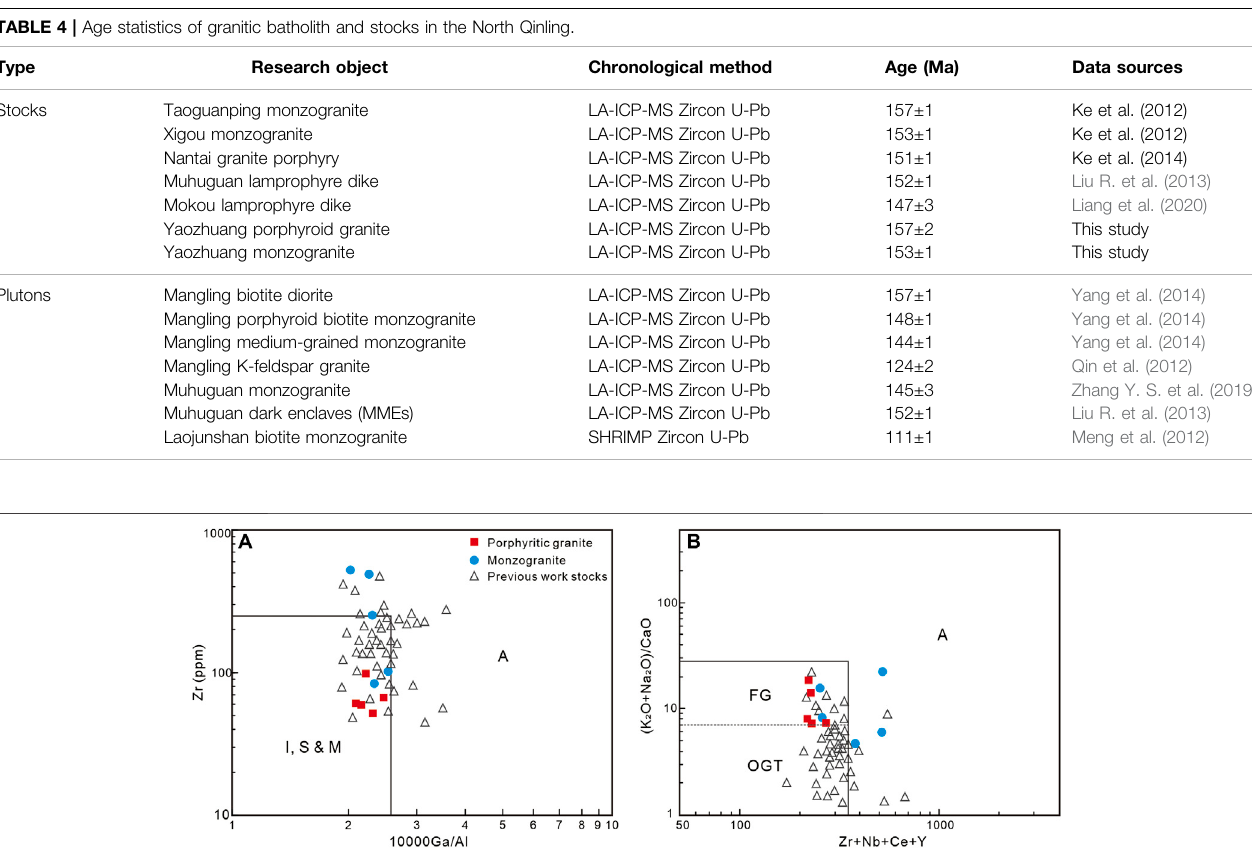
FIGURE 6 | Zr-10000Ga/Al diagram [ (A) after Joseph et al., 1987] and (K 2 O + Na 2 O)/CaO-Zr + Nb + Ce + Y diagram [ (B) after Joseph et al., 1987; previous work stocks data after Ke et al., 2012a; Qin et al., 2012; Yang et al., 2014; Hu et al., 2017; Zhang Y. S. et al., 2019].